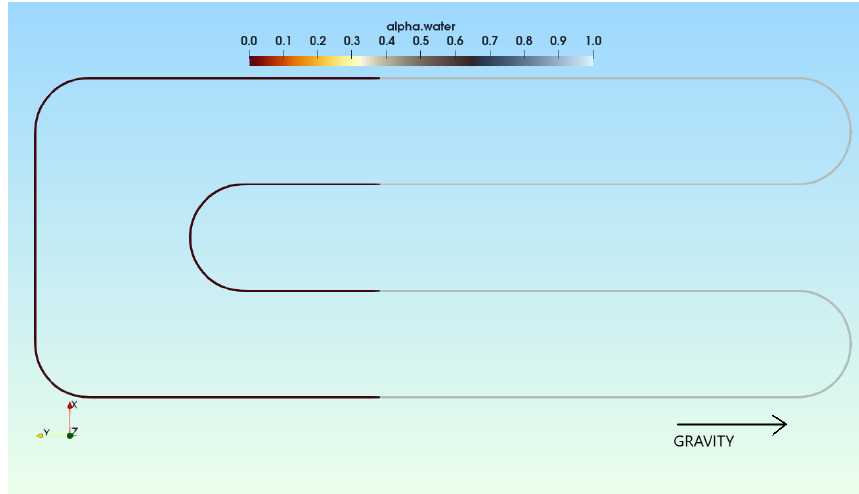
Figure 4. Initial distribution of ethanol for each case.